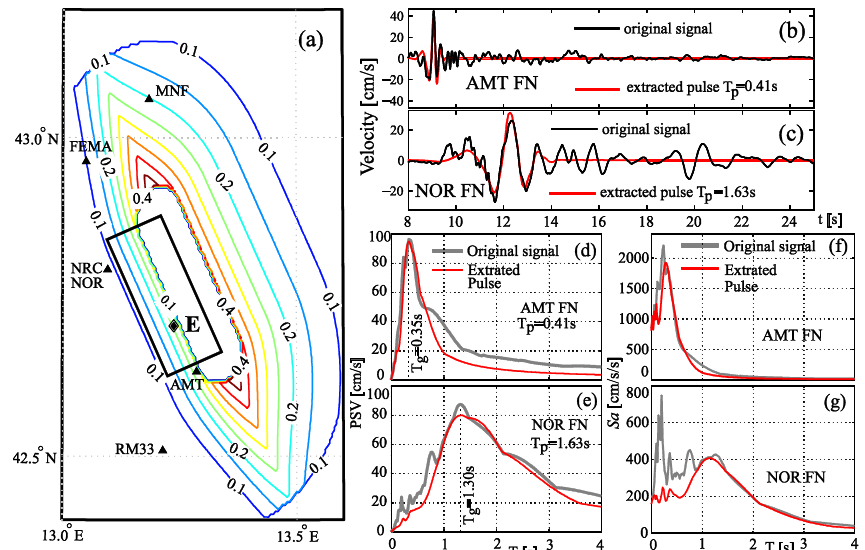
Figure 2. Equal probability of pulse occurrence contours, according to the model of Iervolino and Cornell (2008), plotted against the surface projection of the rupture plane (a), velocity time-history and extracted pulse of AMT FN component (b) and NOR FN (c), pseudo-velocity spectra (PSV) of the extracted pulses plot- ted against PSV of the original signal for the FN components of AMT (d) and NOR (e), pseudo-acceleration spectra of the extracted pulses plotted against Sa of the original signal for the FN components of AMT (f) and NOR